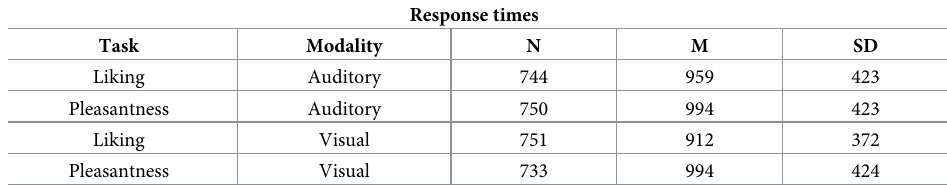
Table 1. Summary statistics of the response times.